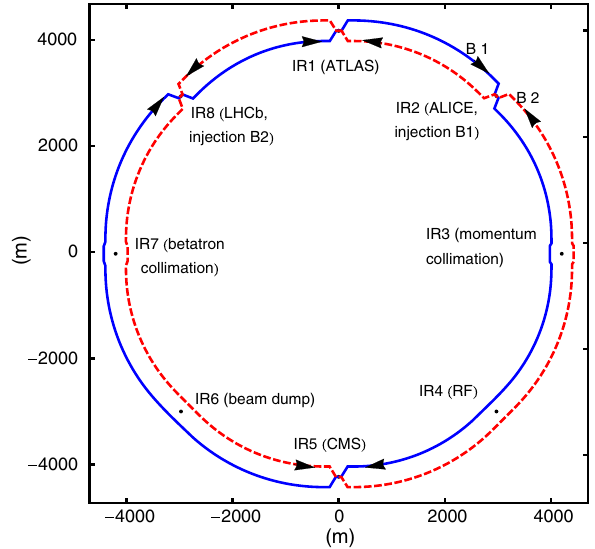
FIG. 1. Schematic layout of the (HL-)LHC (from [28]). Beam 1 (B1) and beam 2 (B2) are shown, respectively, in solid blue and dashed red. The beam separation is not to scale.